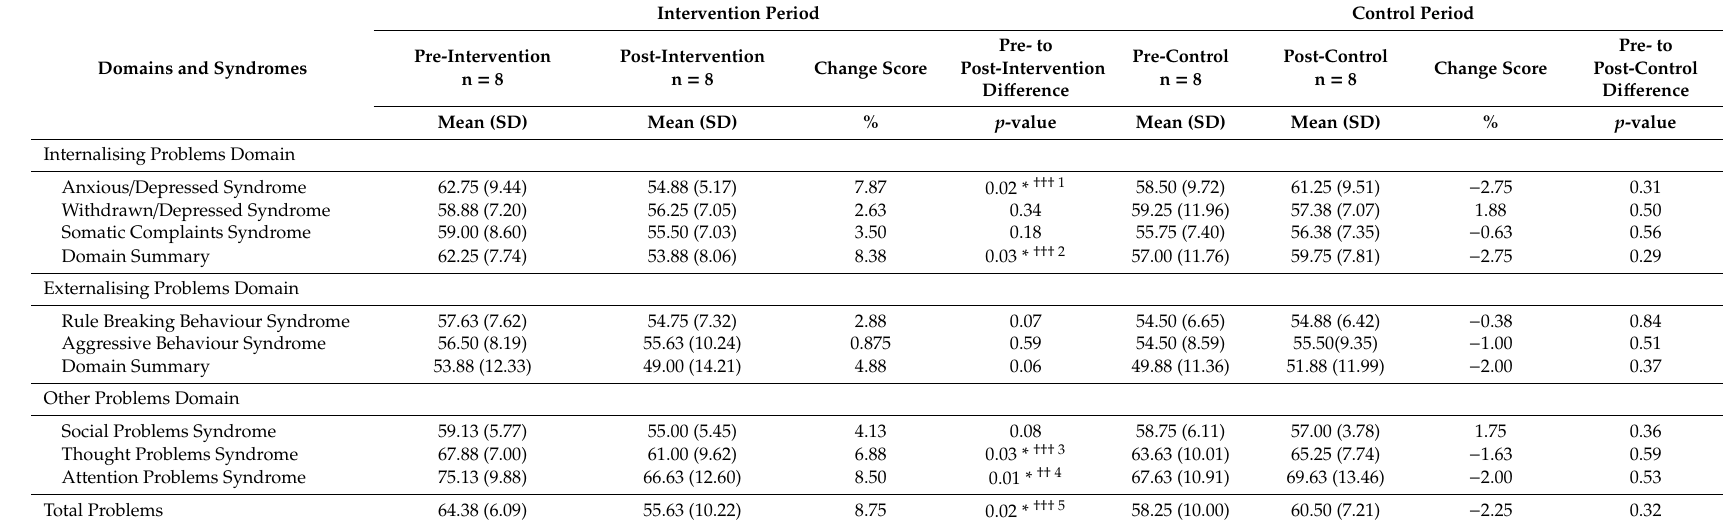
* Indicates a significant di ff erence between pre- and post-intervention scores. † = small e ff ect size; †† = medium e ff ect size; ††† = large e ff ect size. (Degrees of freedom) = t critical score: 1 t(7)